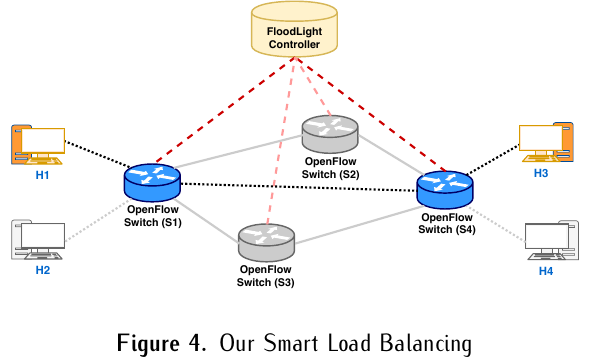
Figure 4. Our Smart Load Balancing